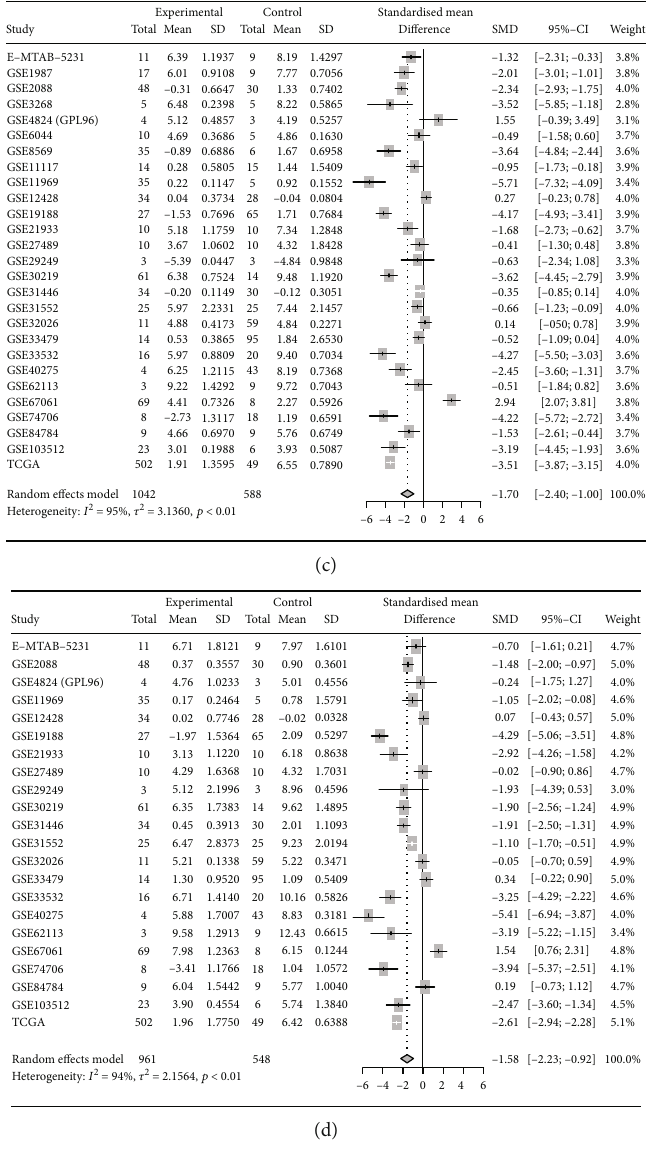
Figure 10: The integrated SMD of four prognosis-related hub genes expression in LUSC. (a-d) Forest plots of SMD for ETS1, CYR61, EDNRB, and LRRK2, respectively. SD: standard deviation; SMD: standardized mean di ff erence; CI: con fi dence